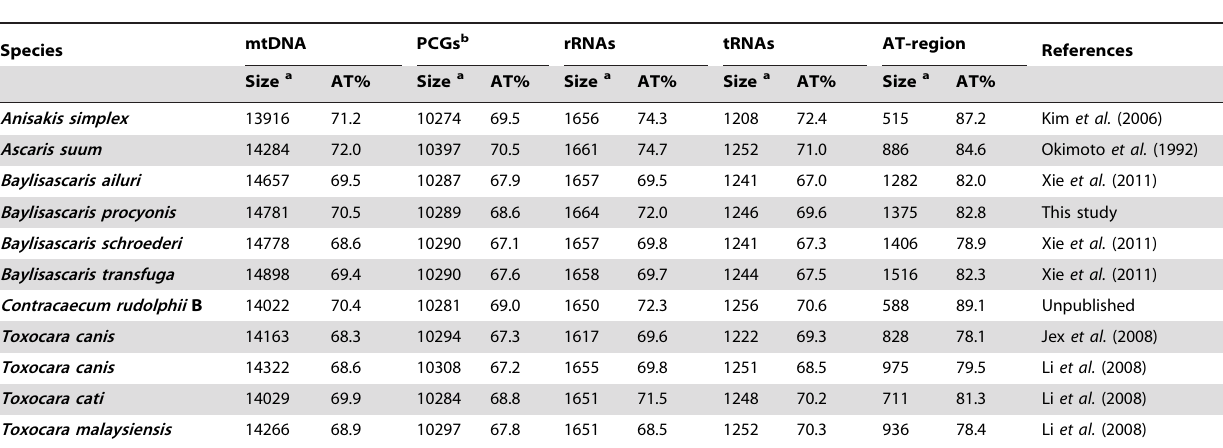
Table 1. Size and nucleotide composition of different genomic regions in 11 ascarids reported within Ascaridida.